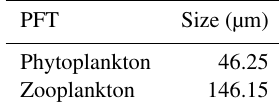
Table A1. Size of the different plankton functional types (µm) used during the simulations.